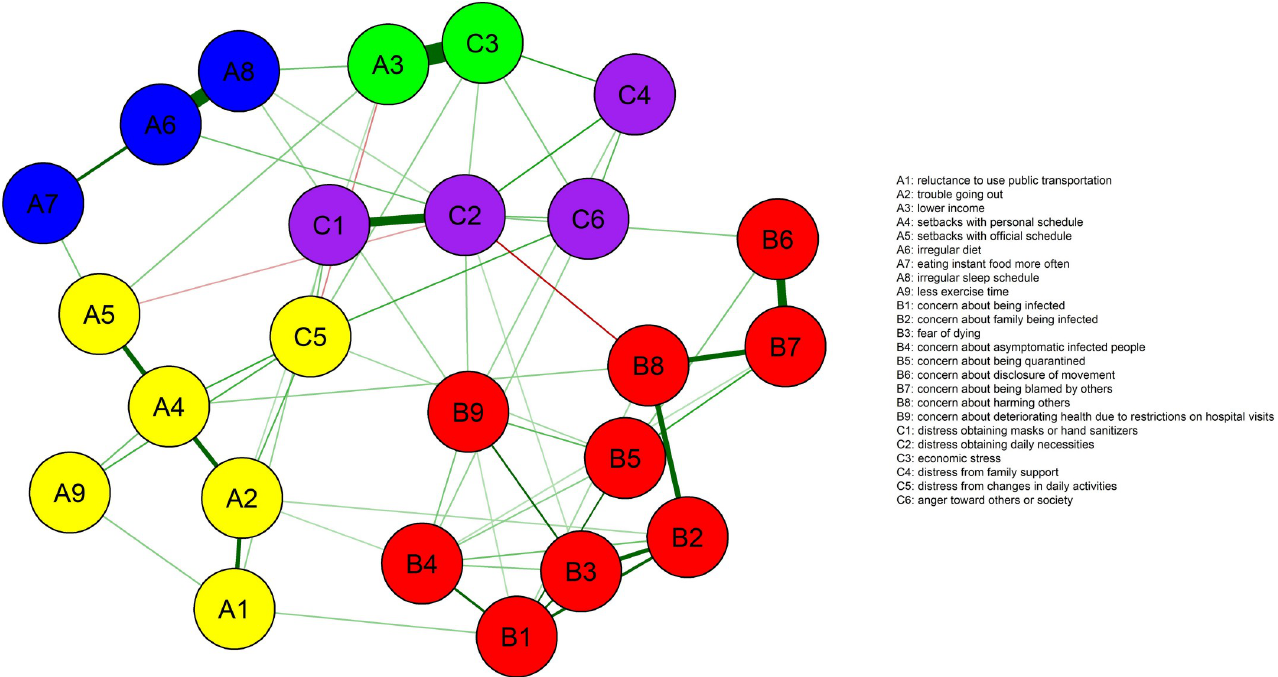
Fig 1. Network of the responses to unusualness due to COVID-19 based on a regularized partial correlation via the extended Bayesian information criterion graphical least absolute shrinkage and selection operator. The 24 nodes are grouped into five communities of ‘fear of infection’ (in red), ‘difficulty in outside activities’ (yellow), ‘economic loss’ (green), ‘disturbance in eating and sleeping’ (blue), and ‘adaptive stress’ (purple). The thickness of the edges represents the magnitude of the correlation. Positive correlations are displayed as green and negative correlations are displayed as red.